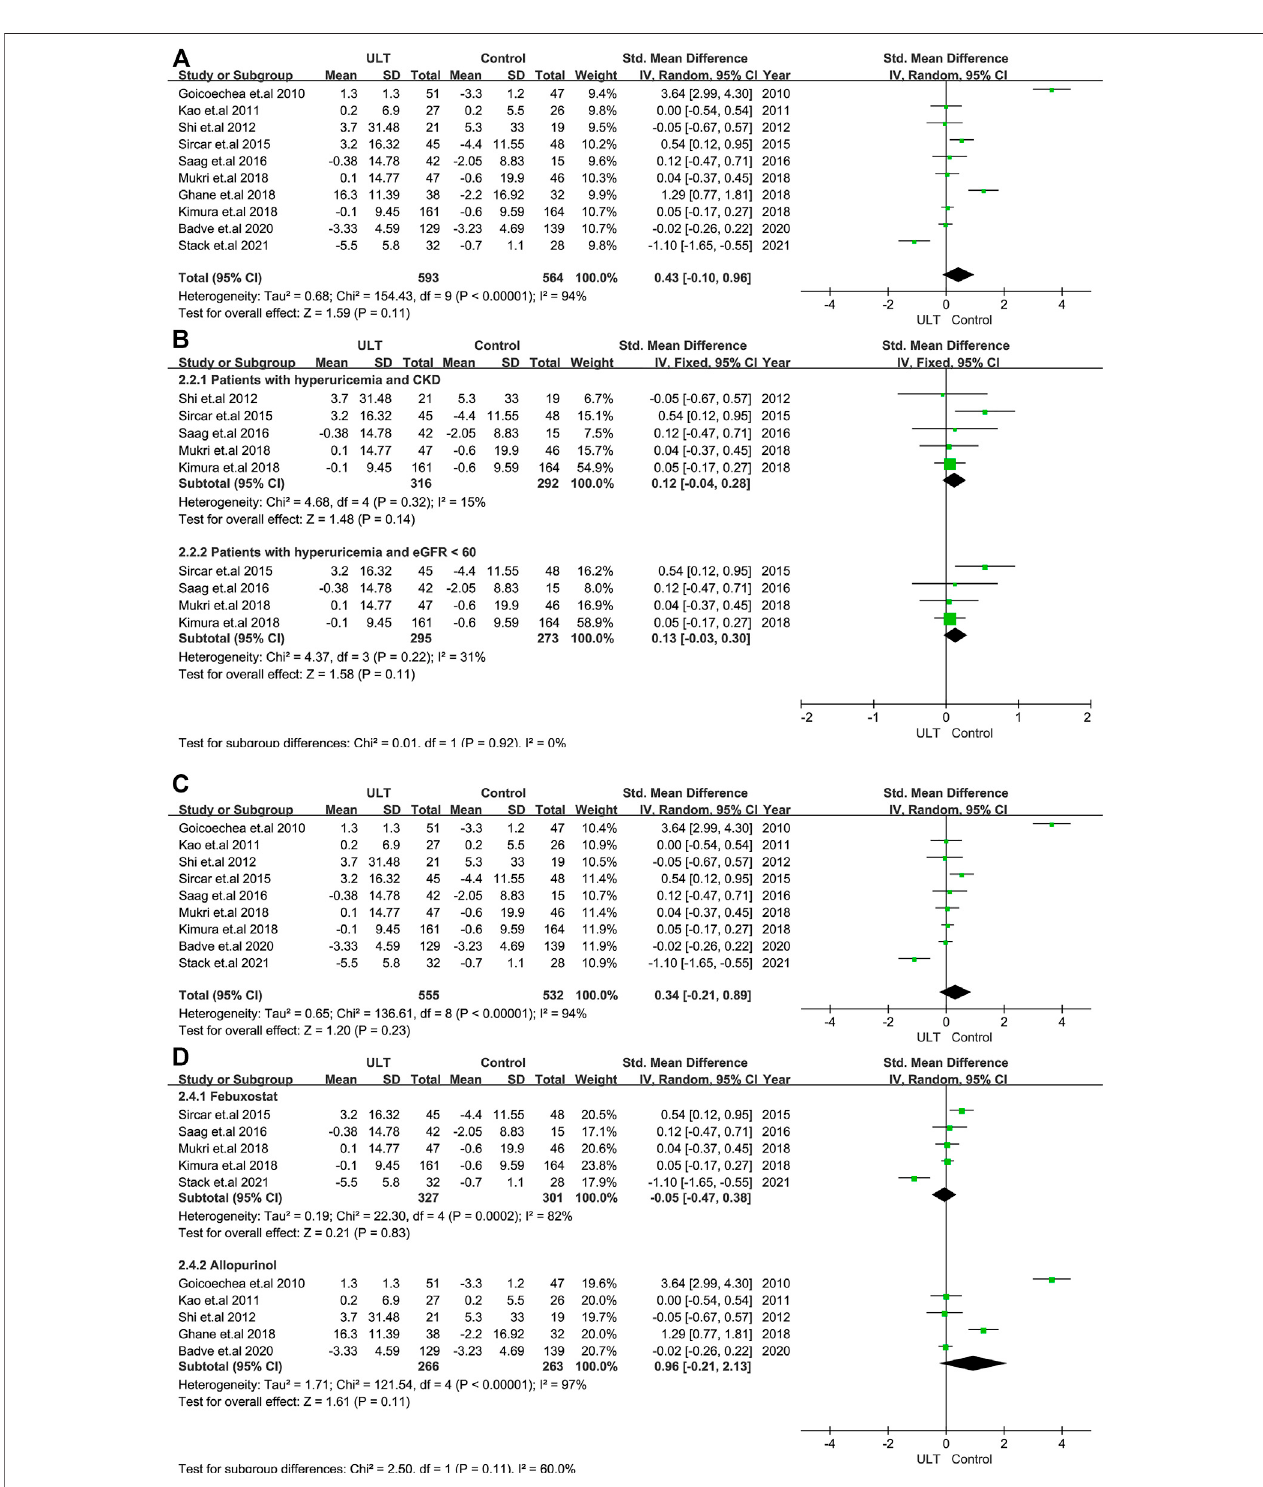
FIGURE 3 | The effect of ULT compared with the group on eGFR (A) All patients. (B) Subgroup analysis of patients with hyperuricemia and CKD or patients with hyperuricemia and eGFR < 60 ml/min/1.73 m 2 . (C) Subgroup analysis including patients with a treatment duration of 6 months or over. (D) Subgroup analysis for ULT drugs including febuxostat and allopurinol. Abbreviations: SMD, standard mean difference; CI, con fi dence interval; eGFR, estimated glomerular fi ltration rate.